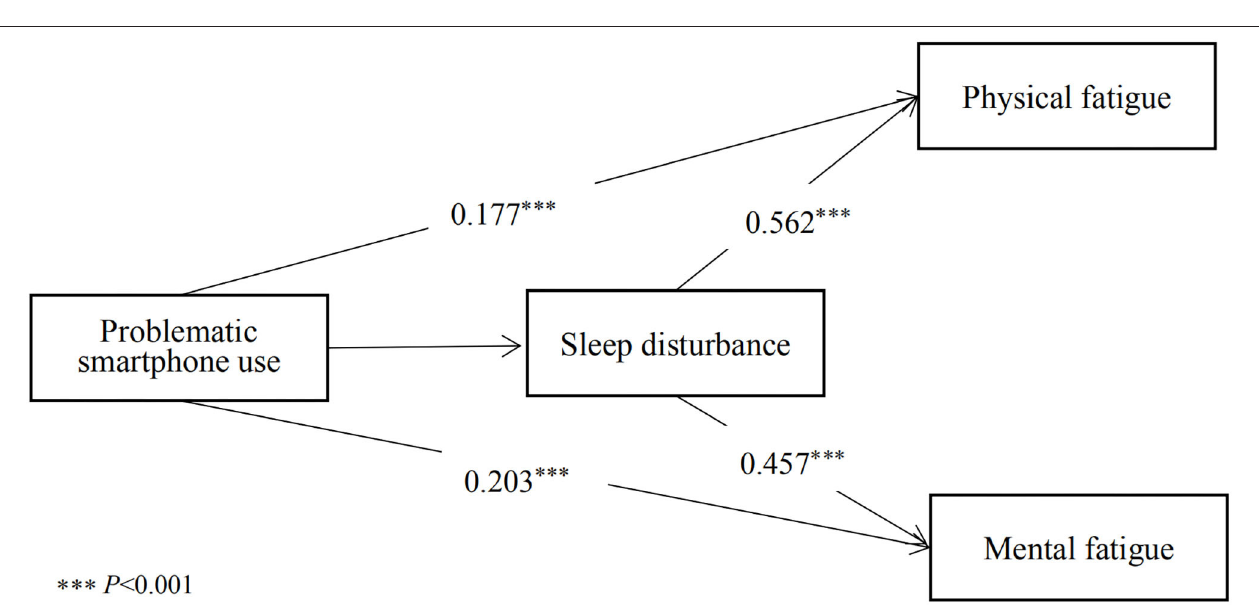
FIGURE 1 | Mediation models of problematic smartphone use, sleep disturbance, physical fatigue, and mental fatigue.